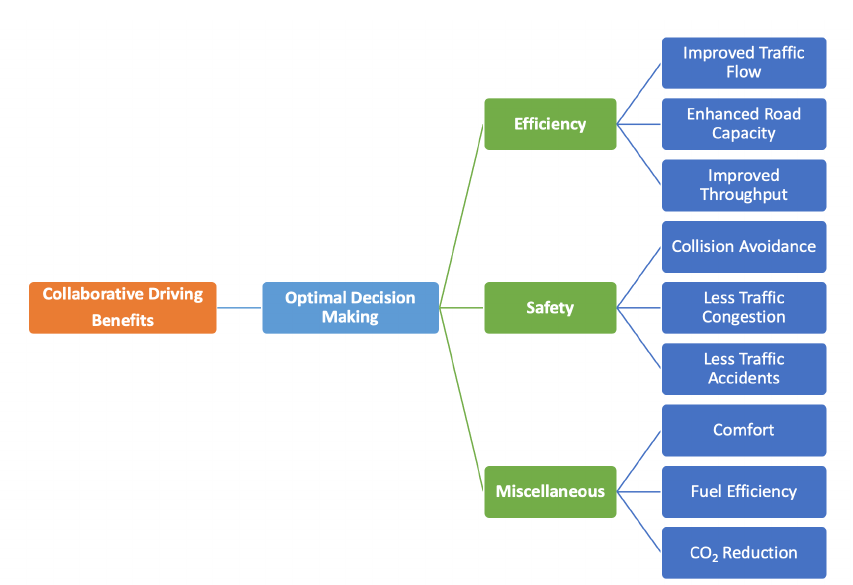
Figure 3. Classification of cooperative driving